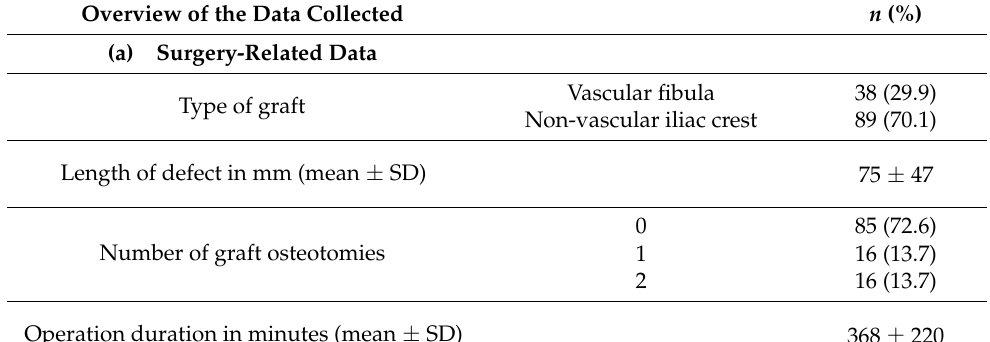
Table 4. Overview of the Data Collected from the Patient Cohort. Overview of the Data